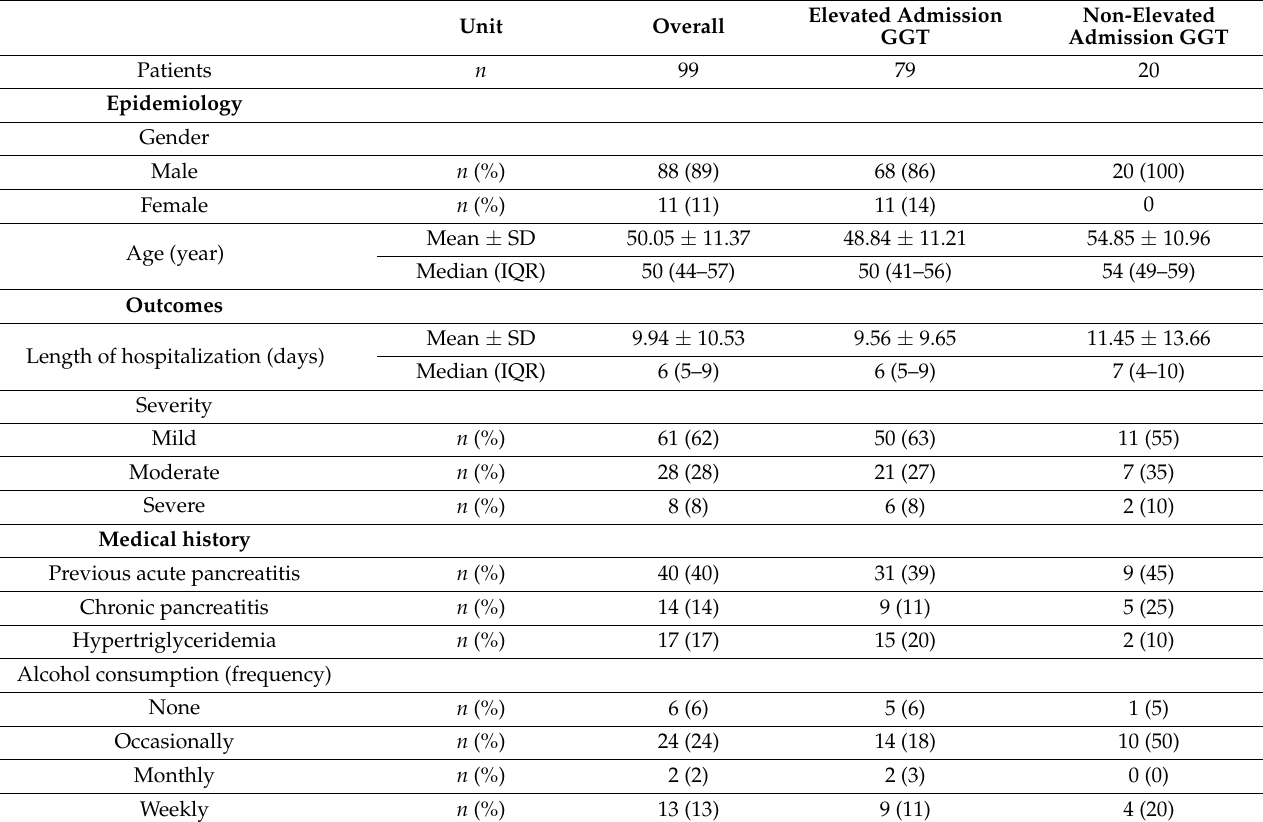
Table 1. Summary of patient characteristics and laboratory